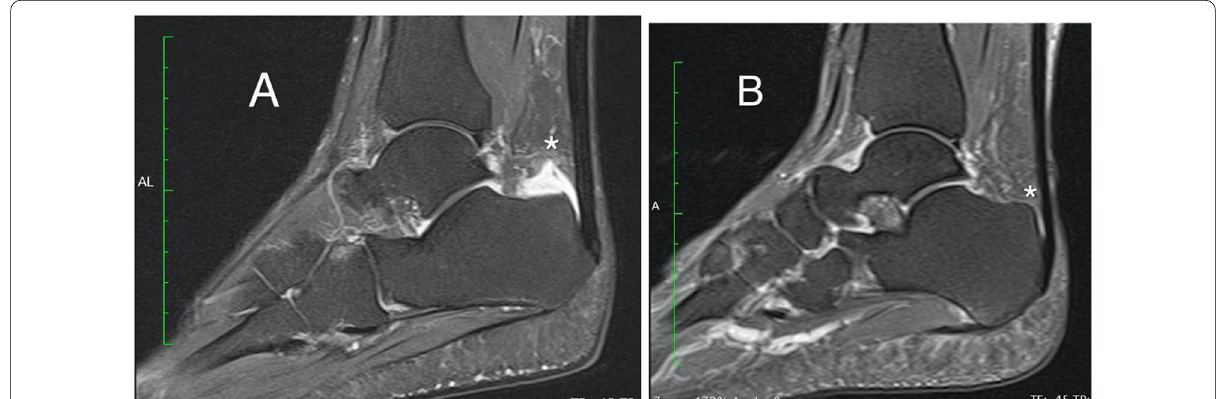
Fig. 2 MRI of the Ankle of a Patient With HAAP and in a Patient with Osteoarthritis. Liquid distension of the deep retrocalcaneal bursa in a HTLV-1 patient ( A ), and in a patient with osteoarthritis ( B ). Deep retrocalcaneal bursa +